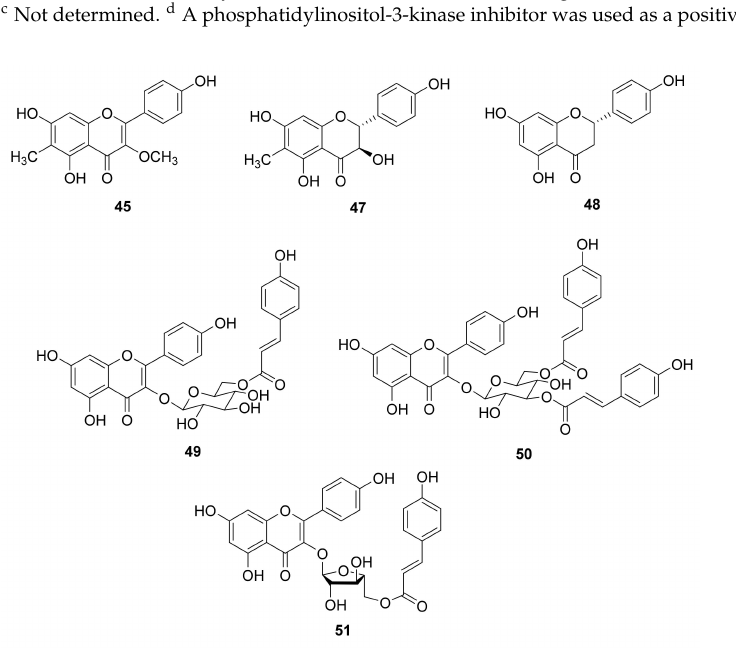
Figure 2. Structures of anti-inflammatory principles 45 , 47 , 48 , 49 , 50 , and 51